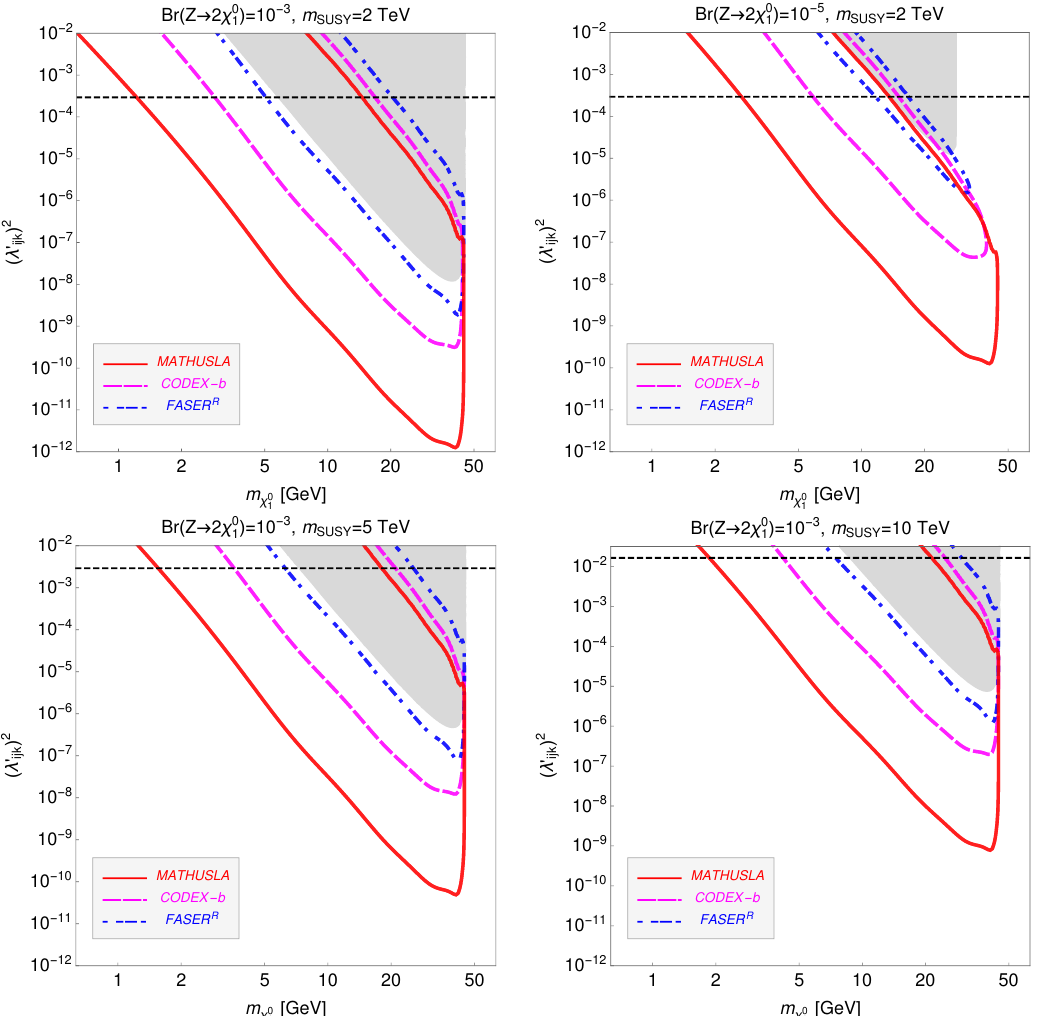
Figure 6 . Sensitivity estimates for CODEX-b, FASER R and MATHUSLA in the plane (cid:21) 0 lightest neutralino mass. In the top row we compare the sensitivities for two di(cid:11)erent values of Br( Z ! (cid:31) 0 (cid:31) 0 ). The bottom row shows the change in reach for larger values of scalar masses, see 1 1 text. The grey area is our estimate for the excluded region from the search for sterile neutrinos at DELPHI [14] using a displaced vertex search. The horizontal line is the current limit on (cid:21) 0 from the absence of neutrinoless double beta decay [65]. Note that the latter does not depend on Br( Z ! (cid:31) 0 (cid:31) 0 1 1